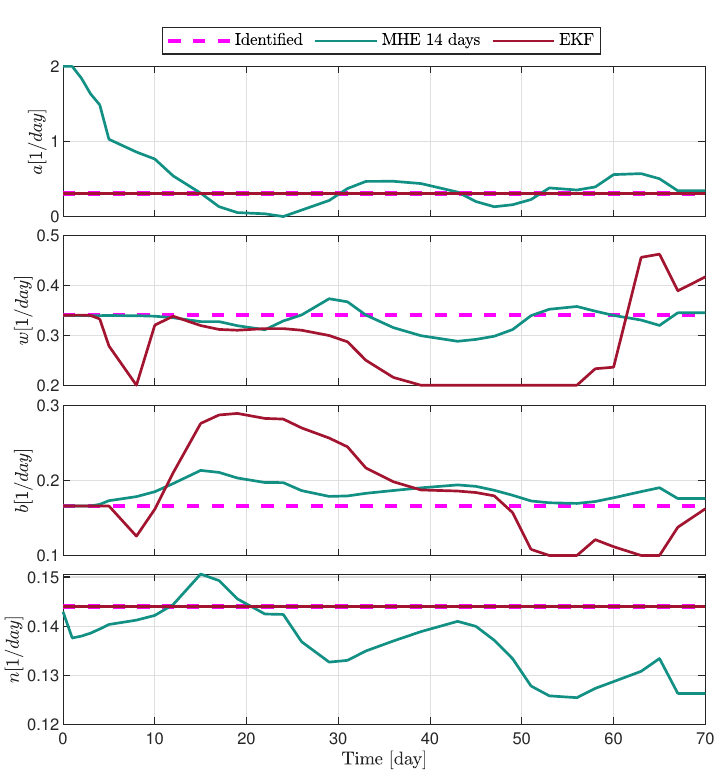
Figure 12. Estimated parameters of PLD3